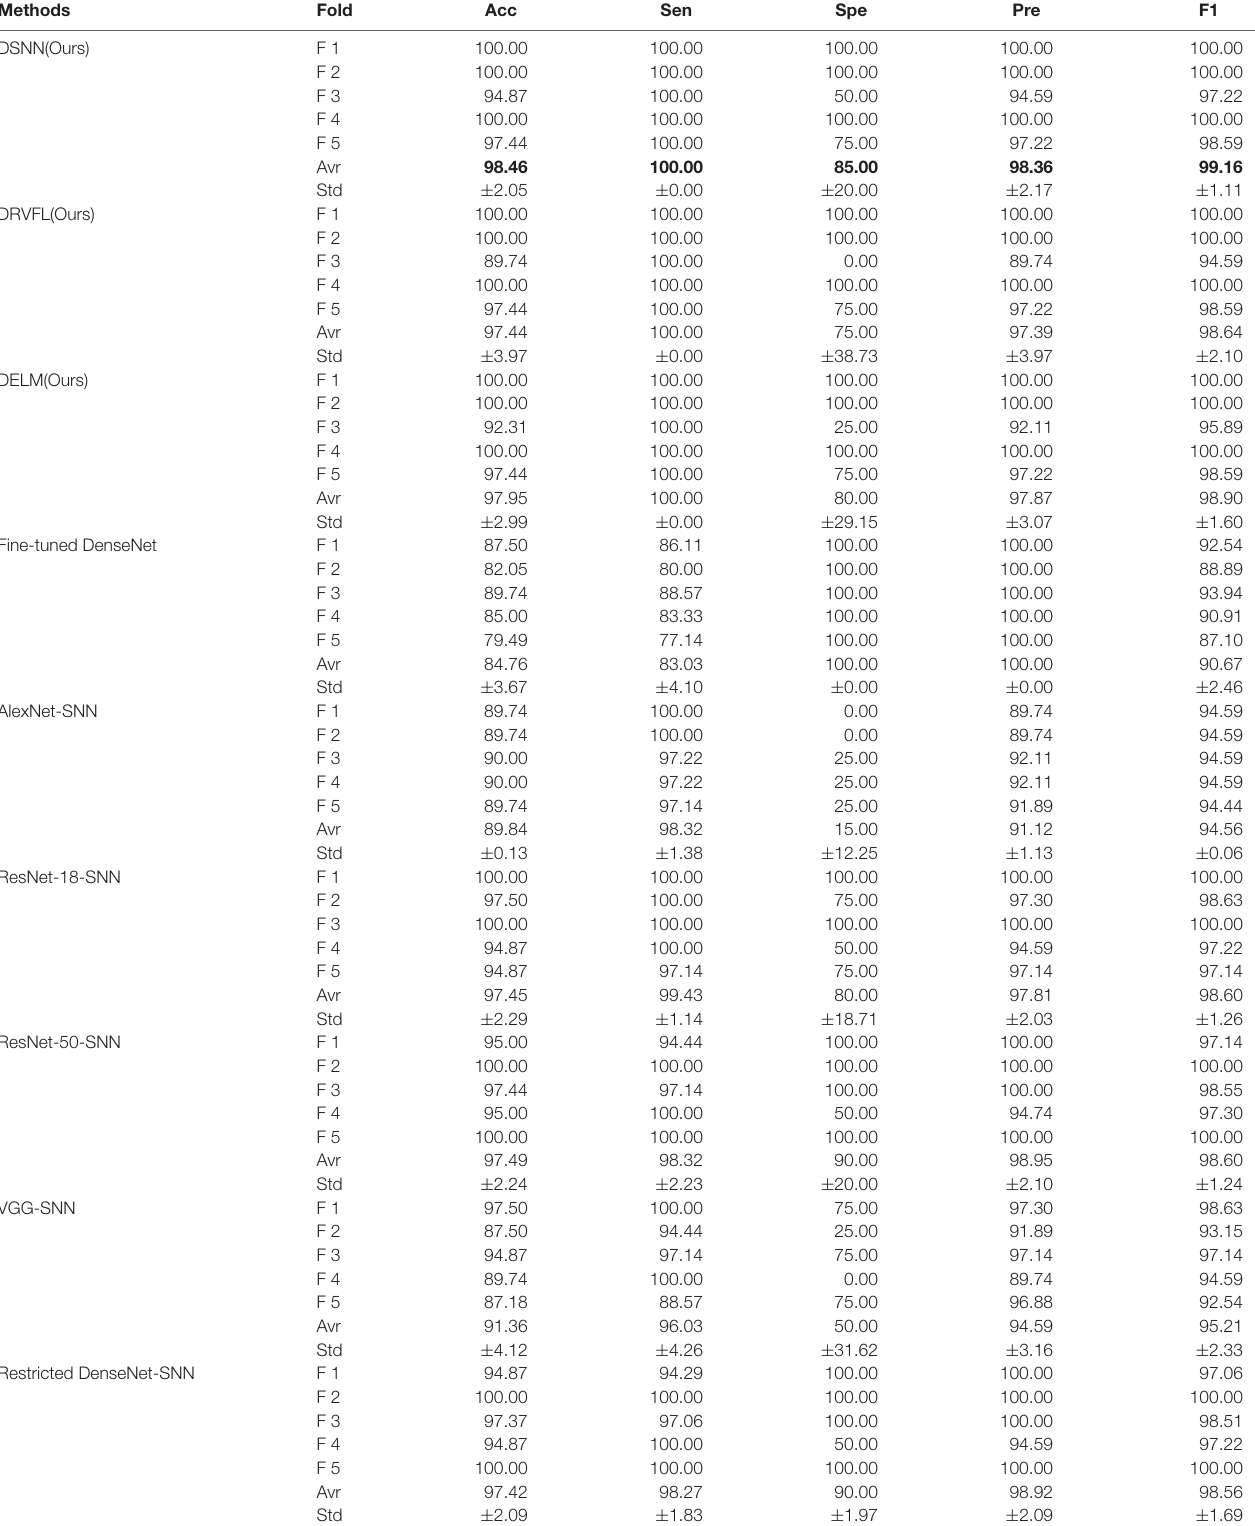
TABLE 6 | The classification performance based on five-fold cross-validation (unit: %). Methods Fold